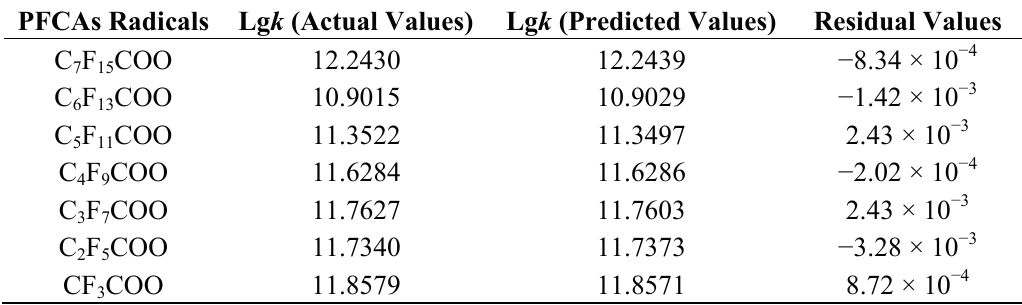
Table 5 . The actual values, predicted values and residual values of the model ( T = 298.15